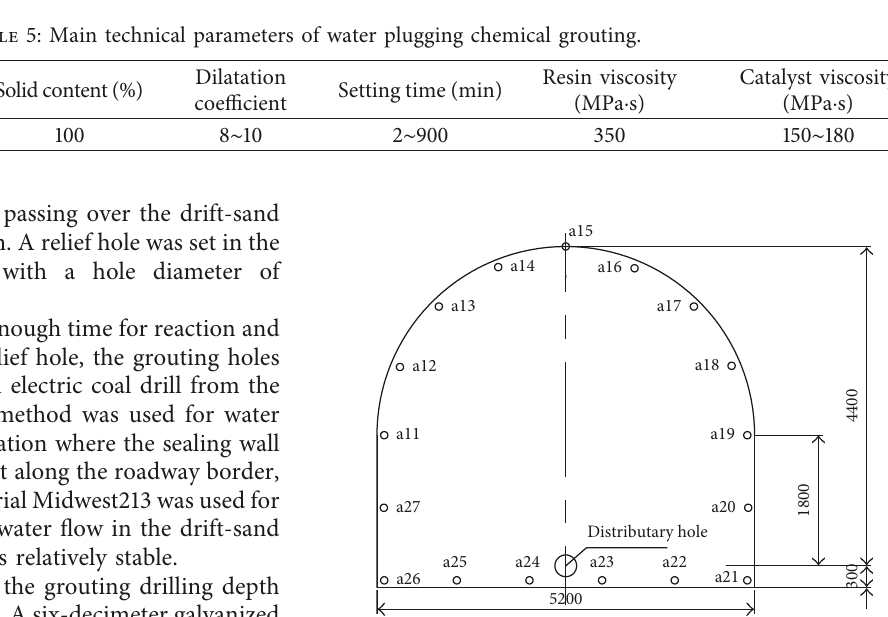
Figure 3: Layout of the water plugging well